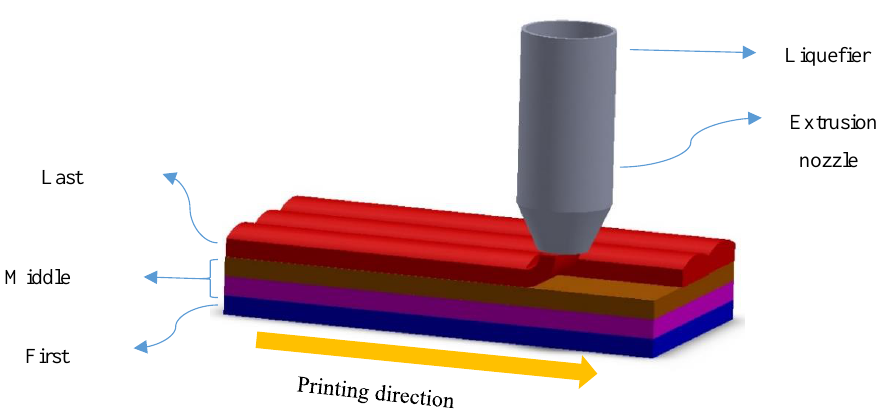
Figure 1. A schematic of the fused deposition modeling (FDM) method.